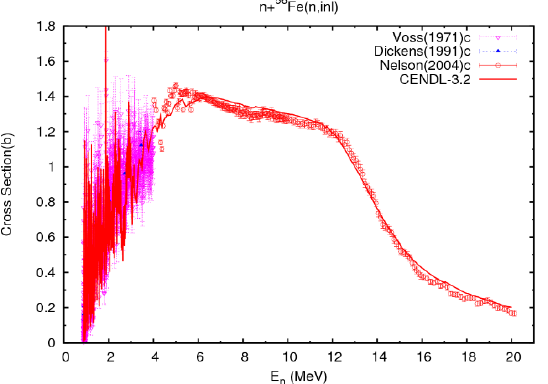
Fig. 7. The comparison between the 56 Fe(n,inl) reaction cross section in CENDL-3.2 and experimental data